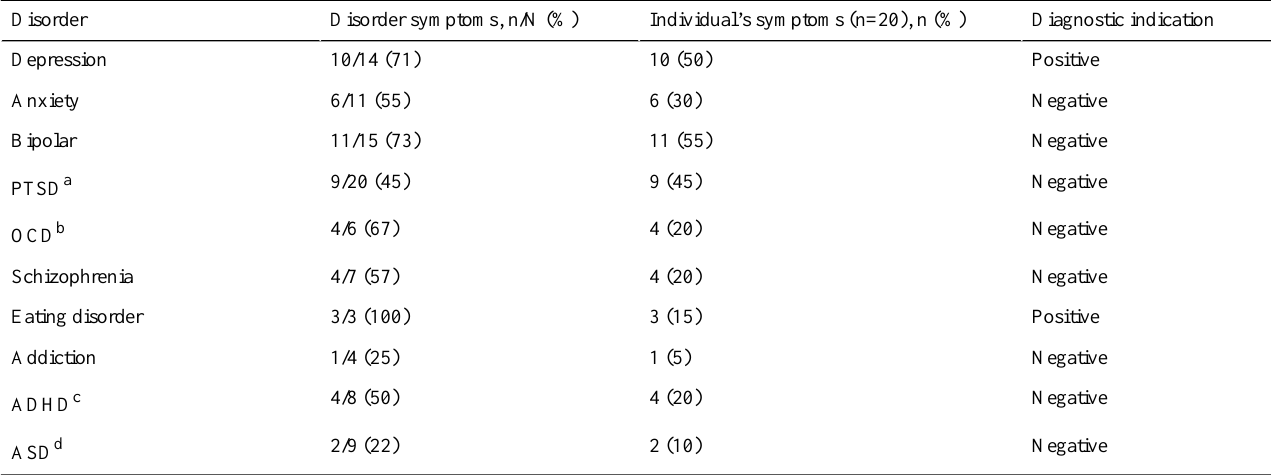
Table 1. Example Mental Health Quotient output for Diagnostic and Statistical Manual of Mental Disorders, Fifth Edition mapping across 10 different mental health disorders for one